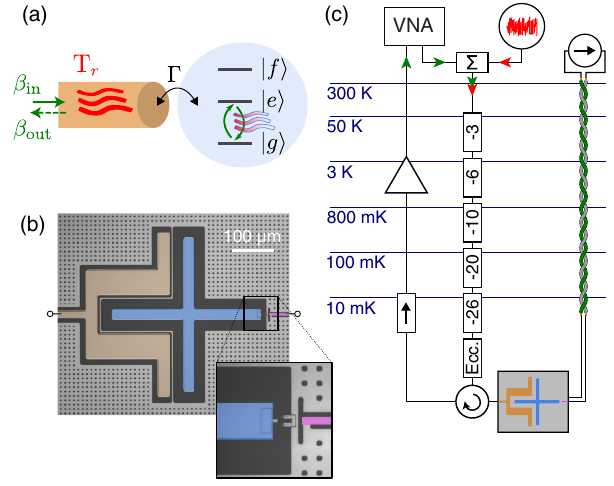
FIG. 1. Primary thermometry of propagating microwaves. (a) Concept: A ladder-type emitter is strongly coupled (with rate Γ ) to the end of a waveguide. We monitor the scattering of a weak coherent tone, β (green straight arrow), resonant with the in ground-to-first-excited-state transition of the emitter. Thermal photons in the waveguide at temperature T (wavy red lines) r disturb the coherent oscillations of the emitter, leading to a decrease in the amplitude of the coherently scattered signal, β out (green dashed arrow). (b) False-color micrograph of the super- conducting circuit realizing the setting in panel (a): A transmon consisting of a superconducting island (blue) shunted by a superconducting quantum interference device (SQUID) is capac- itively coupled to a coplanar waveguide (orange) and inductively coupled to a flux line (purple). The inset shows a close-up of the SQUID and the flux line. (c) Simplified scheme of the exper- imental setup (see text for details and Appendix A for the full wiring